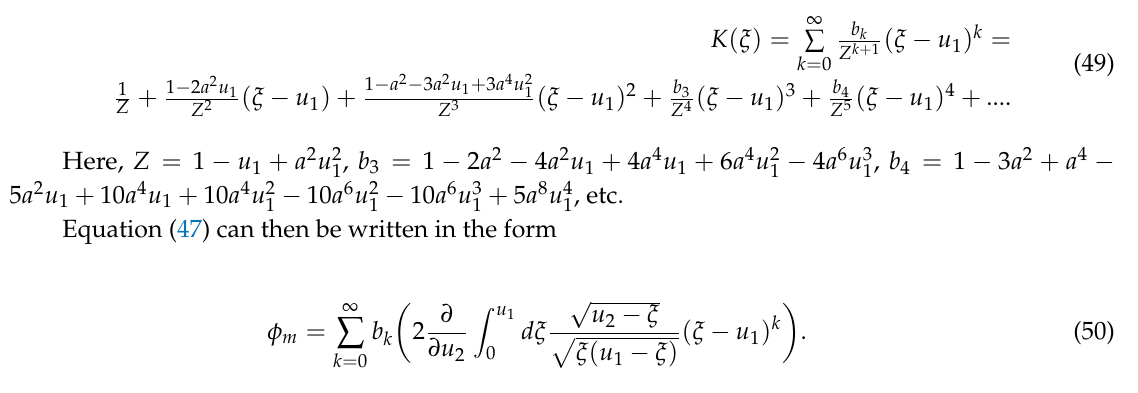
Figure 10. Derivative φ u as function of u for limit parameters a = ± 0.5, i.e., for j + = 1 + j − = 1.25. For a = − 0.5 (left curve), domain u 1 = 0.343 ≤ u ≤ 1 is not accessible by the test